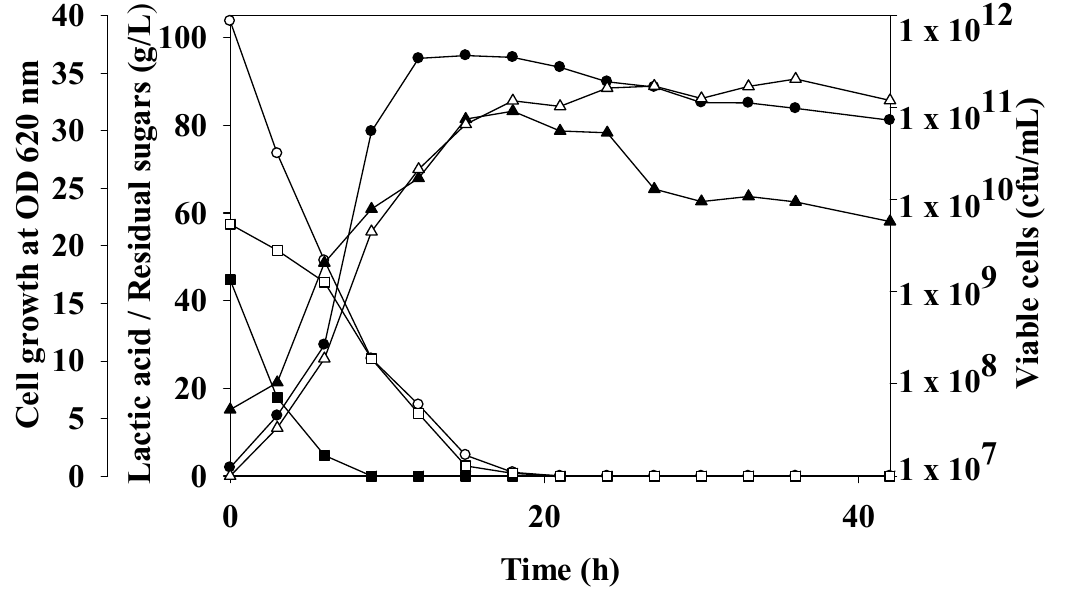
Figure 2. Open batch fermentation of oil palm trunk sap by L. rhamnosus ATCC 10863. Culture was performed in a 2 L fermenter containing 1.2 L working volume at a temperature of 40 °C, agitation speed of 200 rpm, and pH 6.5. Lactic acid ( ● ), residual sugars ( ○ ), glucose ( □ ), fructose ( ■ ), viable cells ( ▲ ), and cell growth at OD 620nm ( ∆ ) was indicated.